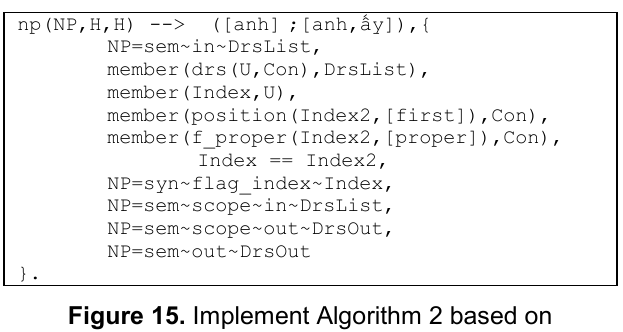
Figure 15. Implement Algorithm 2 based on framework GULP